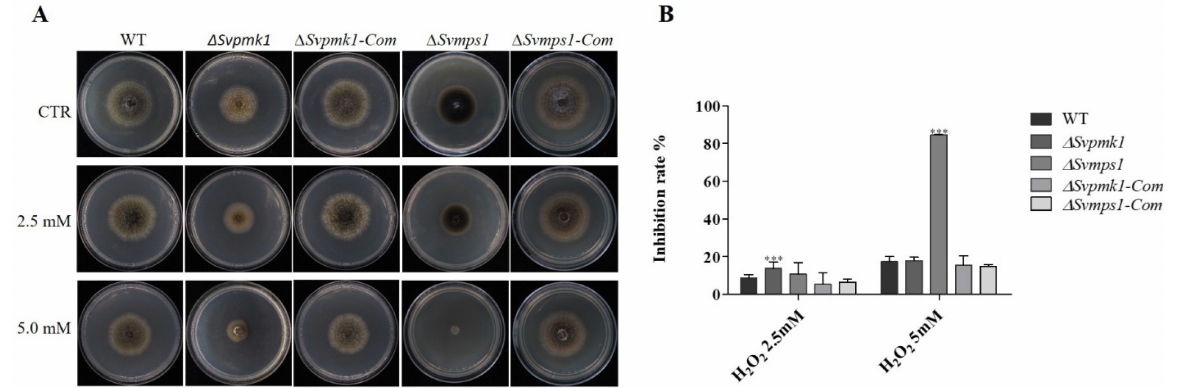
Figure 5. Sensitivity of ∆ Svpmk1 and ∆ Svmps1 to different concentrations of H 2 O 2 . ( A ) Growth phenotype of the WT, mutants and complemented strains under oxidative stress condition. The WT, mutant and complemented strains were cultured on PDA media supplemented with 2.5 and 5.0 mM H 2 O 2 , incubated at 28 ◦ C for 7 days and then sampled for sensitivity assay. CTR was a full-strength PDA without H 2 O 2 . ( B ) The growth inhibition rate of the WT, mutants and complementation strains. Asterisk = p -value (***, p < 0.001). Error bar represents the standard deviation from the mean of three independent repeats with five technical replicates. Statistical analysis was conducted using two-way ANOVA with Tukey’s multiple-comparison test (GraphPad Prism 5).